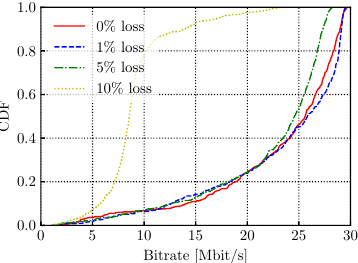
Figure 4. Bitrate distribution with different artificial packet